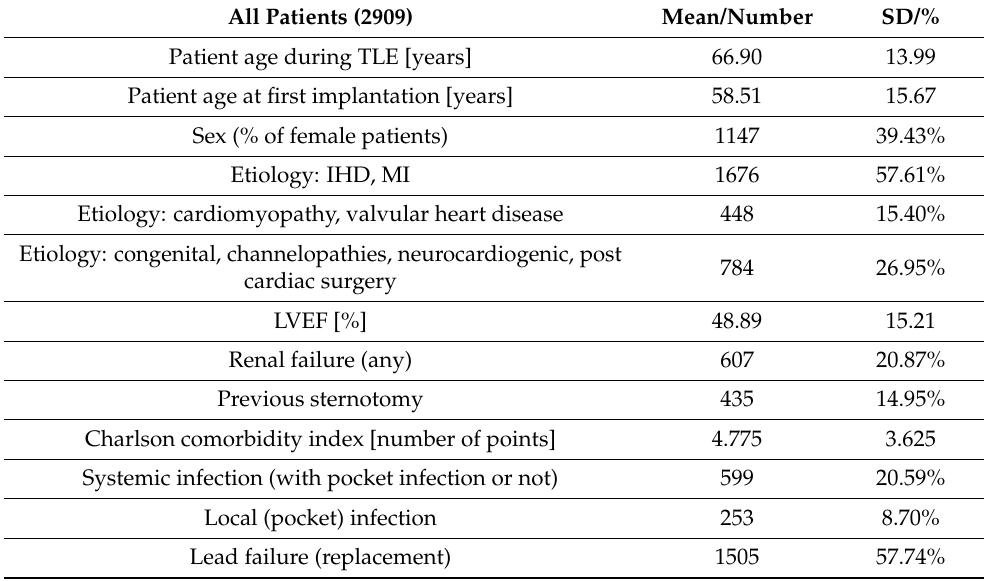
Table 1. Characteristics of the study